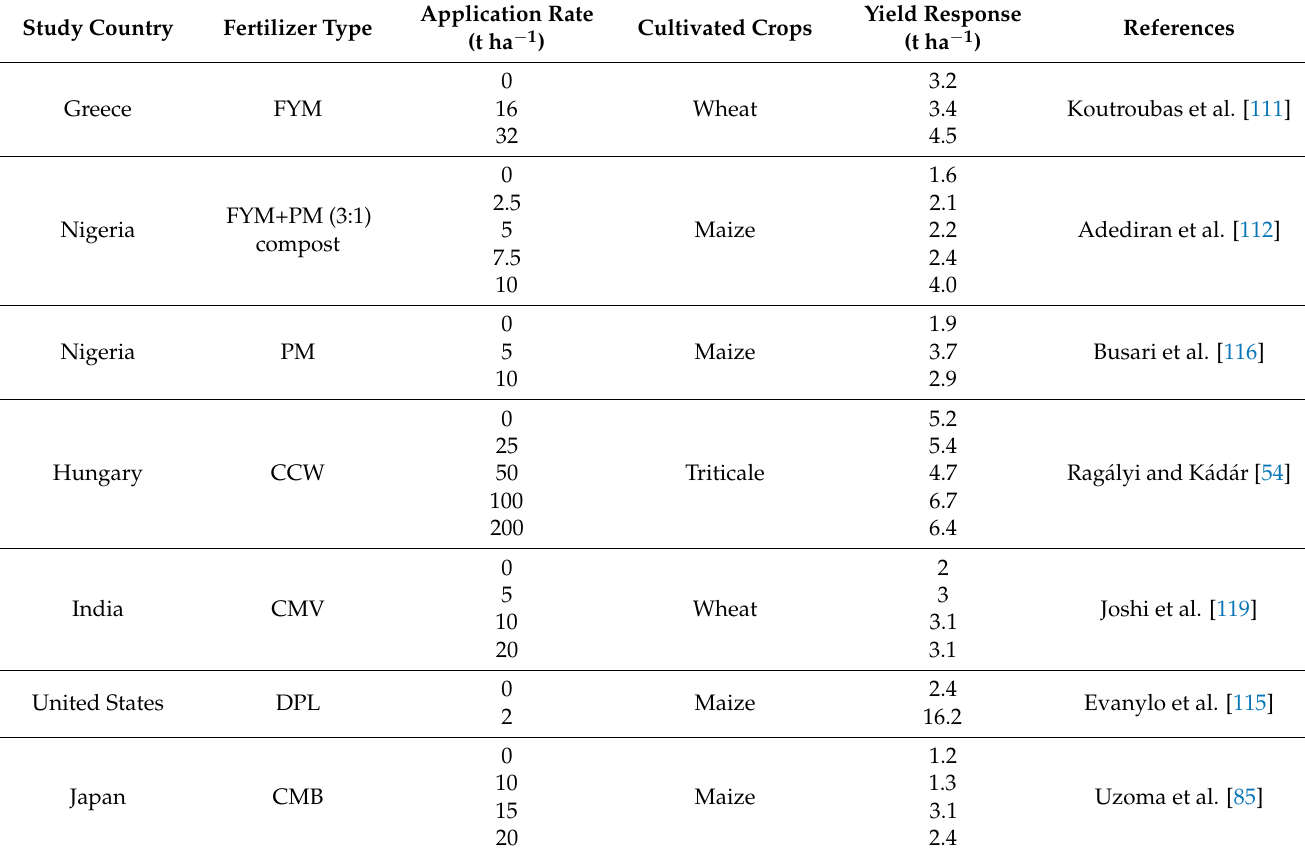
Table 2. Yield potential of various animal-derived amendments at different dosages (expressed as dry matter basis). Study Country